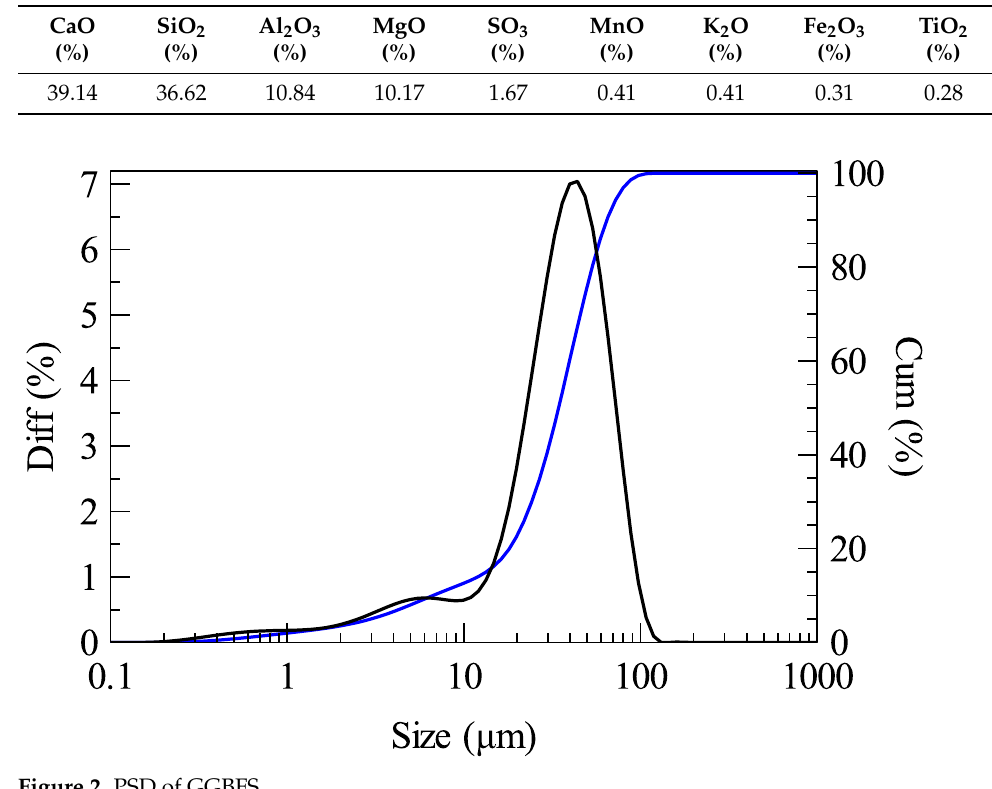
Figure 2. PSD of GGBFS. Figure 2. PSD of